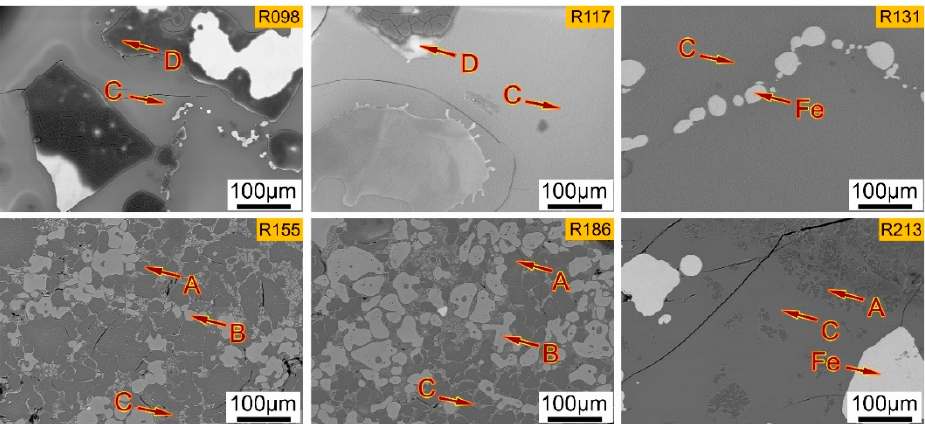
Figure 5. SEM images of dephosphorization slag with magnification of 200 times at different basicities.